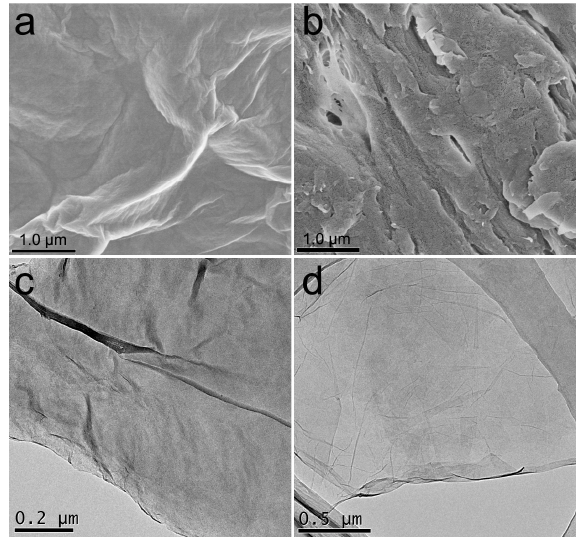
Figure 1. Characterization of graphene oxide (GO) sponge ( a , c ) and carboxylated GO (GO-COOH) sponge ( b , d ). ( a , b ) SEM images; ( c , d ) TEM images.